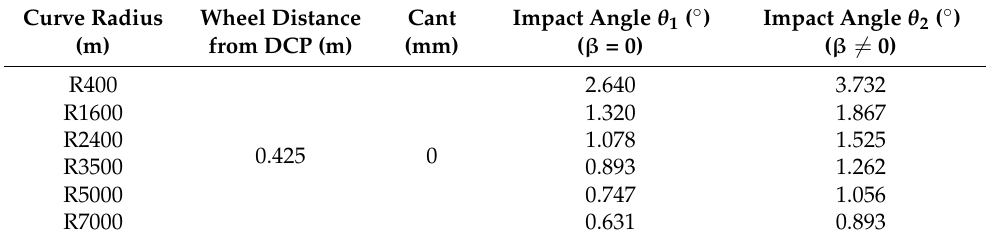
Table 1. Impact angle according to curve radius.